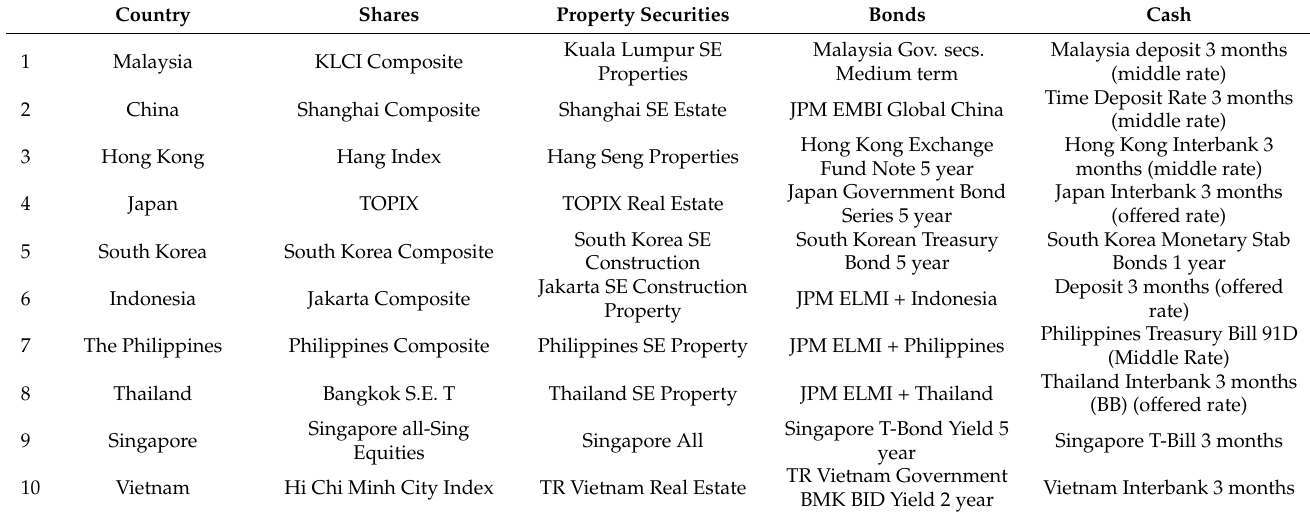
Table 3. Research data for shares real estate securities, bonds and